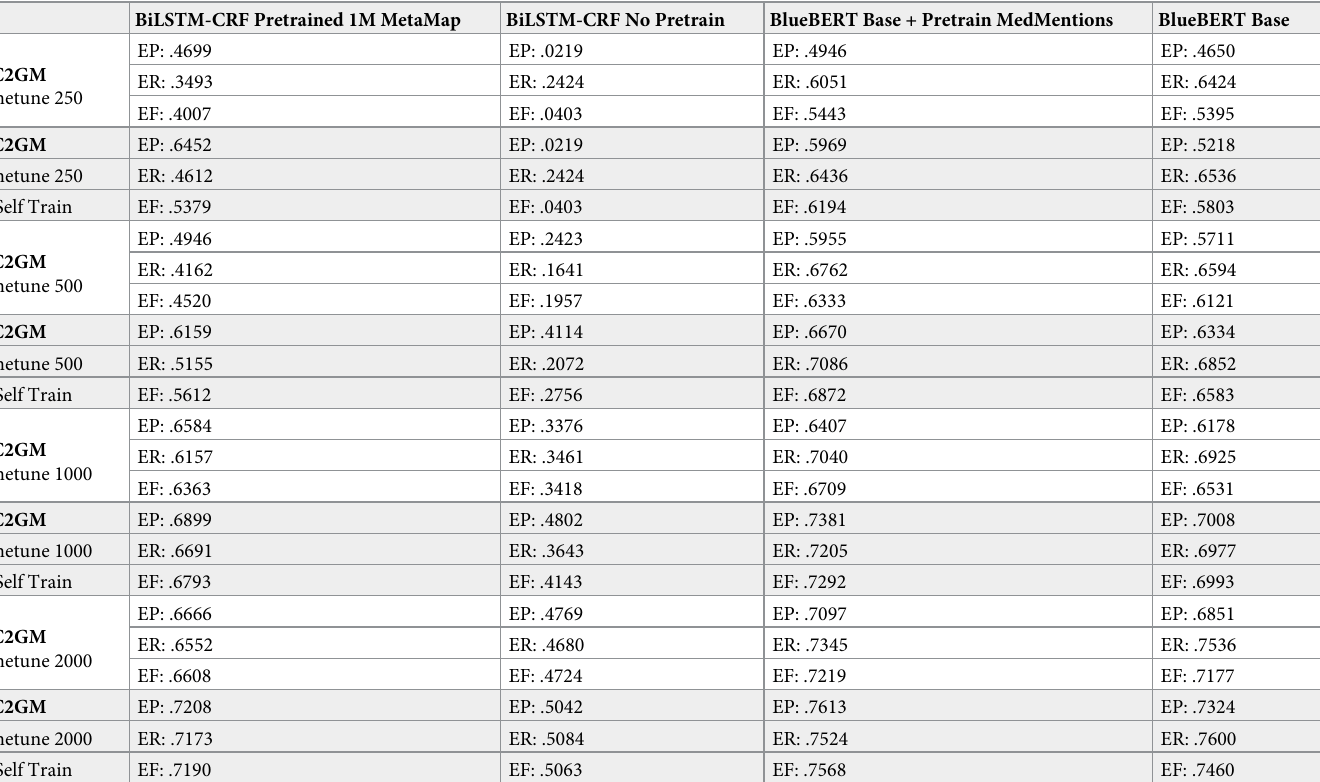
Table 9. Performance of the BiLSTM-CRF and BlueBERT on the BC2GM dataset with and without transfer learning. BiLSTM-CRF Pretrained 1M